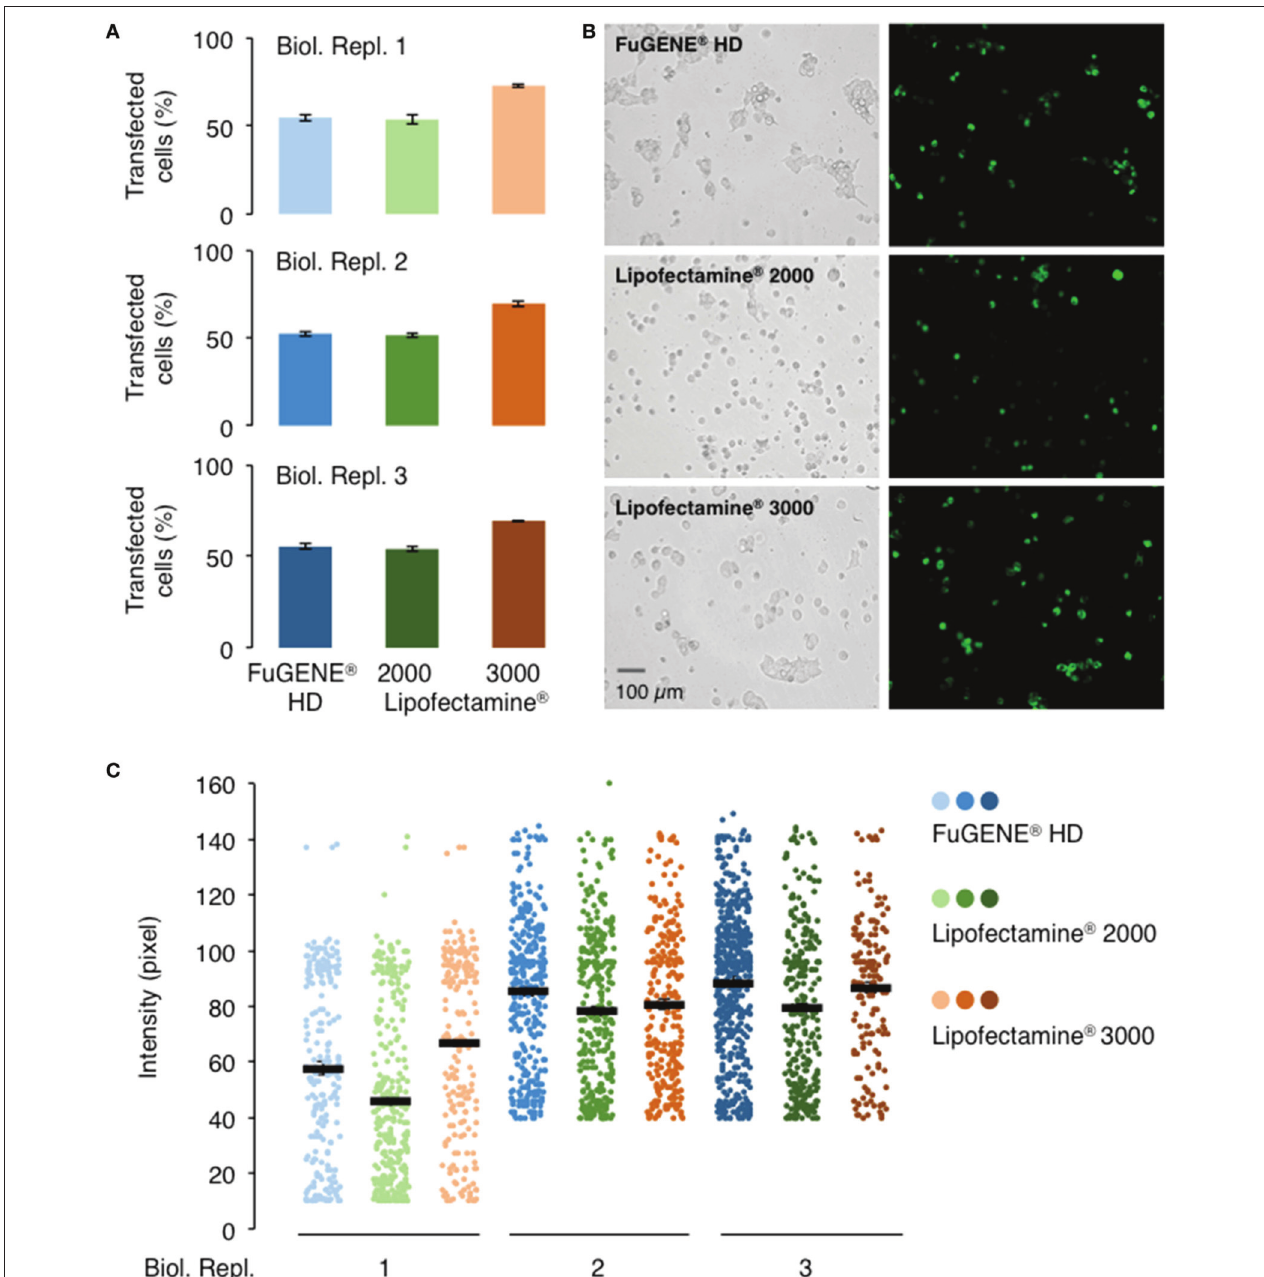
FIGURE 3 | Comparison of different transfection reagents on the transfection and expression efficiencies of AtGORK-EmGFP in HEK-293 cells. HEK-293 cells transfected with AtGORK-EmGFP were used to examine the performance of different transfection reagents in a “reverse” format (see Section Procedure for definition). In general, Lipofectamine ® 3000 outperforms Lipofectamine ® 2000 and FuGENE ® HD in both transfection efficiency (A,B) and protein expression (C) . Lipofectamine ® 2000 and FuGENE ® HD have comparable transfection efficiencies but lower than that of Lipofectamine ® 3000. FuGENE ® HD seems to yield protein expression levels comparable to that of Lipofectamine 3000. A typical 20 × HEK cell image contains 2560 × 1920 pixels and is converted to an 8-bit byte image that on a scale of 0–255 using ImageJ. The lower limit cut-off that represents appreciable and above background fluorescence, was set at 10 pixels for biological replicate 1 but 40 pixels for replicates 2 and 3. Transfection efficiency and protein expression of more than 200 cells in each viewing area were analyzed (see Section Procedure for analysis).